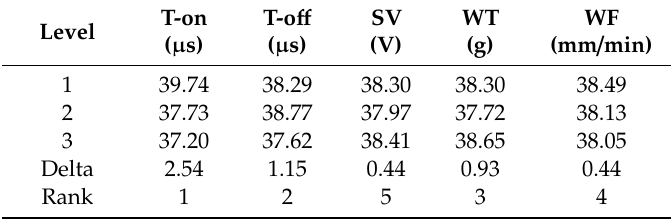
Figure 5. Parametric effects on inter-channel fin thickness (IFT): ( a ) main effects plot and ( b ) interaction plot. Table 6. Signal-to-noise (S/N) ratio analysis of IFT (Larger is better).